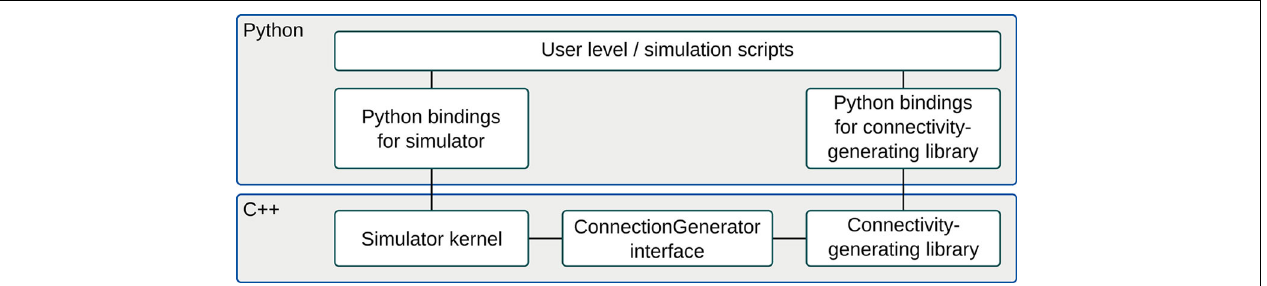
FIGURE 1 | Block diagram of the connection generator interface and the components involved in a typical usage scenario. The central component is the ConnectionGenerator class itself. It can connect to different